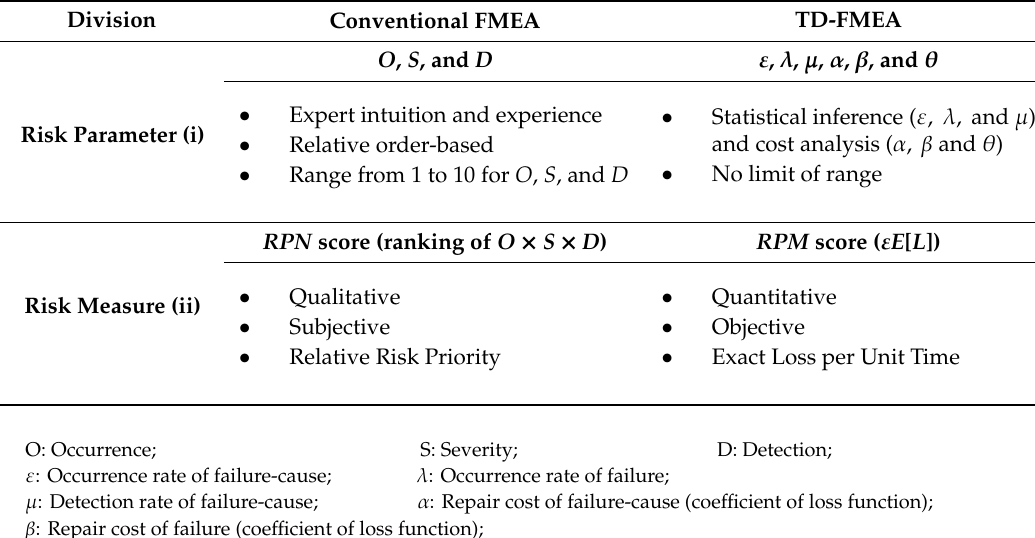
Table 4. Comparison of traditional FMEA and